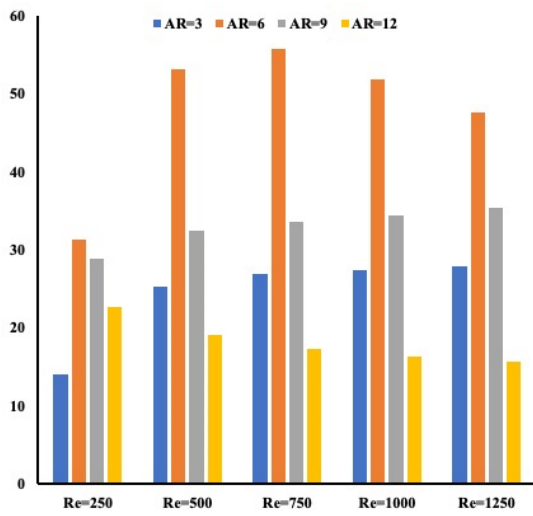
Figure 12. Heat removal for all cases.